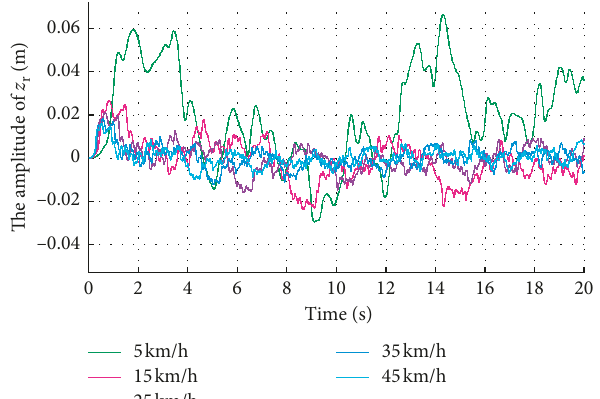
Figure 4: The variation of z